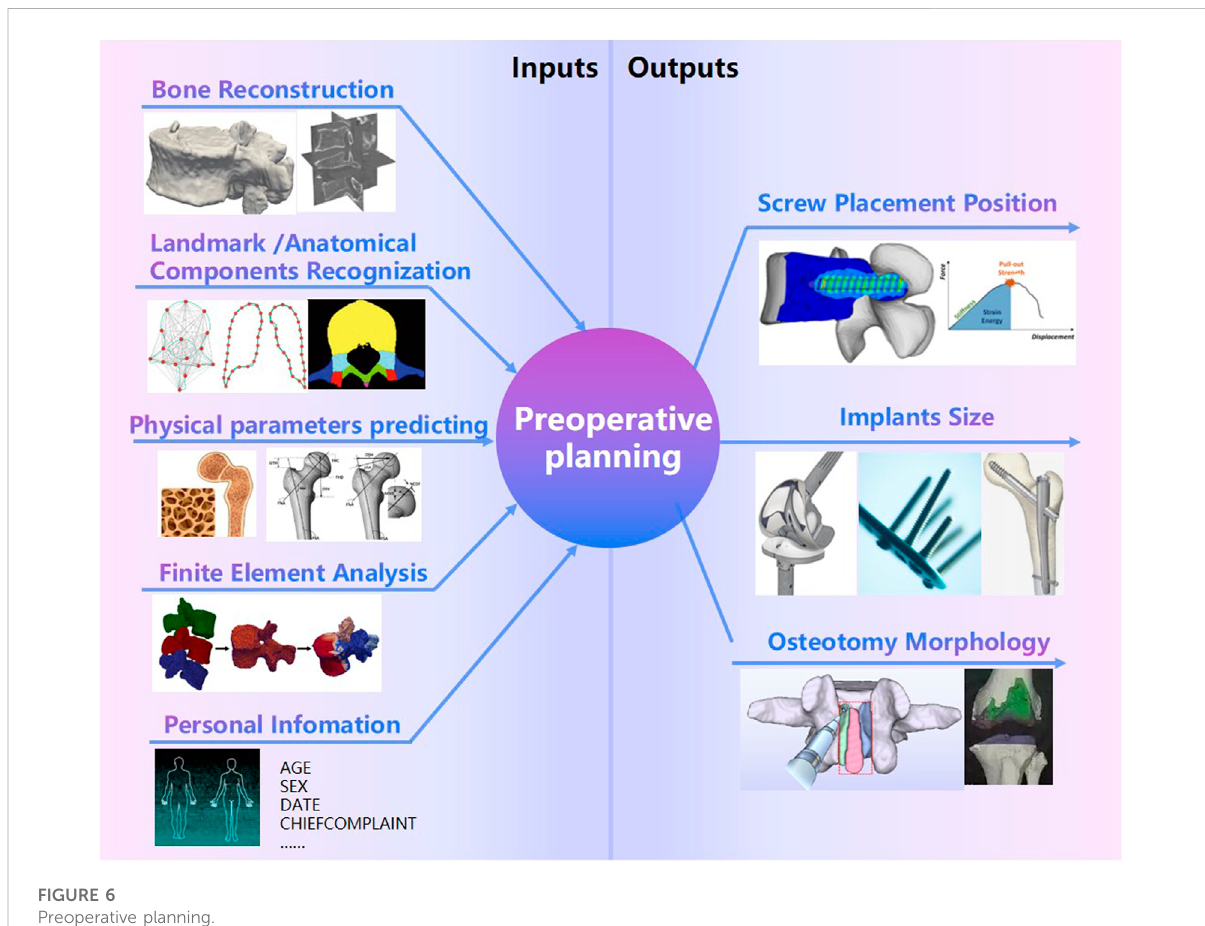
FIGURE 6 Preoperative